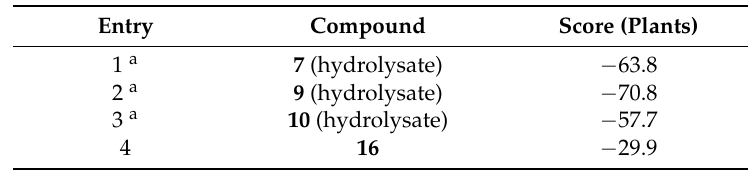
Table 3. The docking scores of FIH-1 with compounds 7 , 9 , 10 , and 16 run on Molegro Virtual Docker